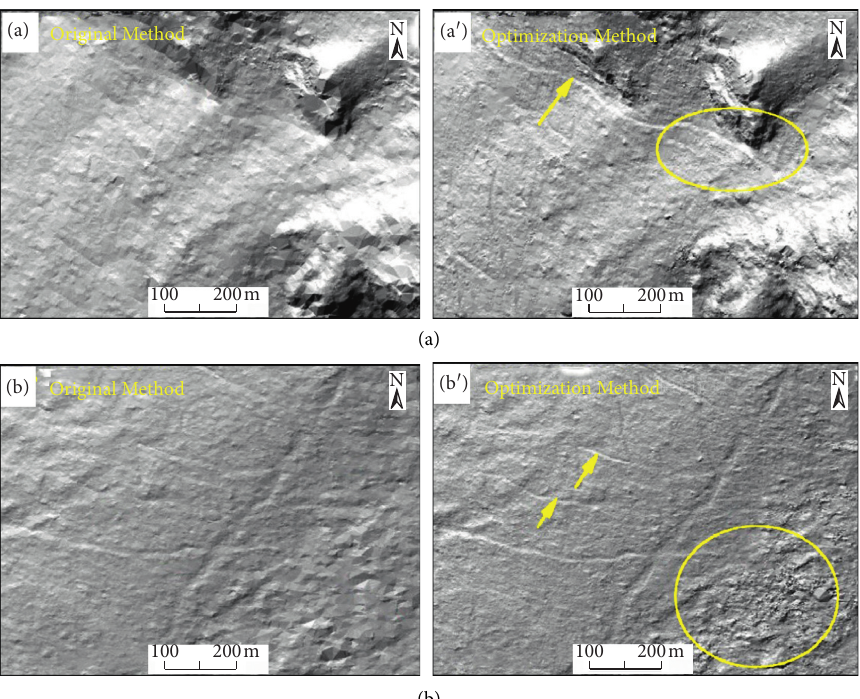
Figure 5: Comparison of the traditional filtering method and the geological filtering method for displaying microgeomorphology: (a, b) the results gained with the traditional filtering algorithm and (a ′ , b ′ ) the results of using the optimization filtering algorithm, which produces smaller landforms (steep hills, clastic rocks).